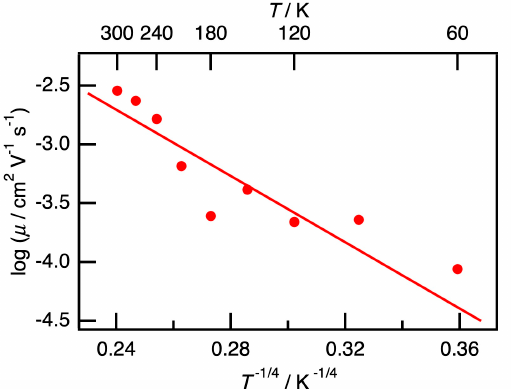
Figure 6. Temperature dependence of µ of P3HT nanofiber composited in PB / PEG blend with φ PB = 0.72 ( > ϕ cI ). The dependence log µ against T − 1 / 4 was almost linear one, thus the carrier transport was suggested to be three-dimensional variable range hopping (VRH) type.